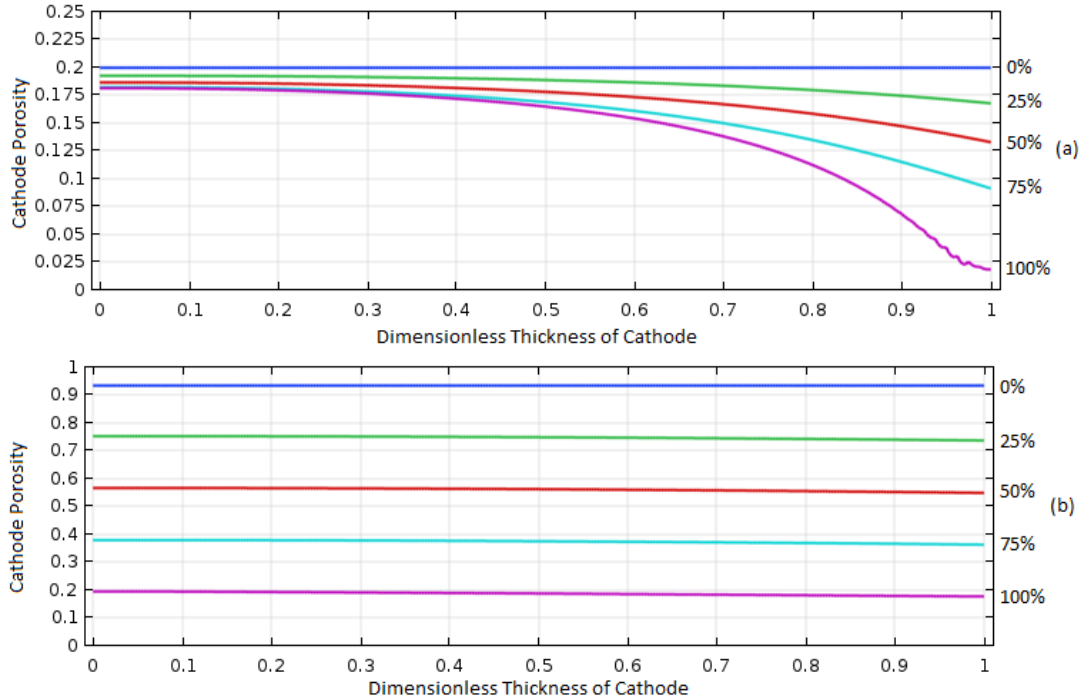
Figure 10. Distribution of cathode porosity from 0% to 100% discharge at 1 A/m 2 for initial porosities of ( a ) 0.2 and ( b ) 0.94, with 0.5 O 2 solubility and 195 µ m cathode thickness.